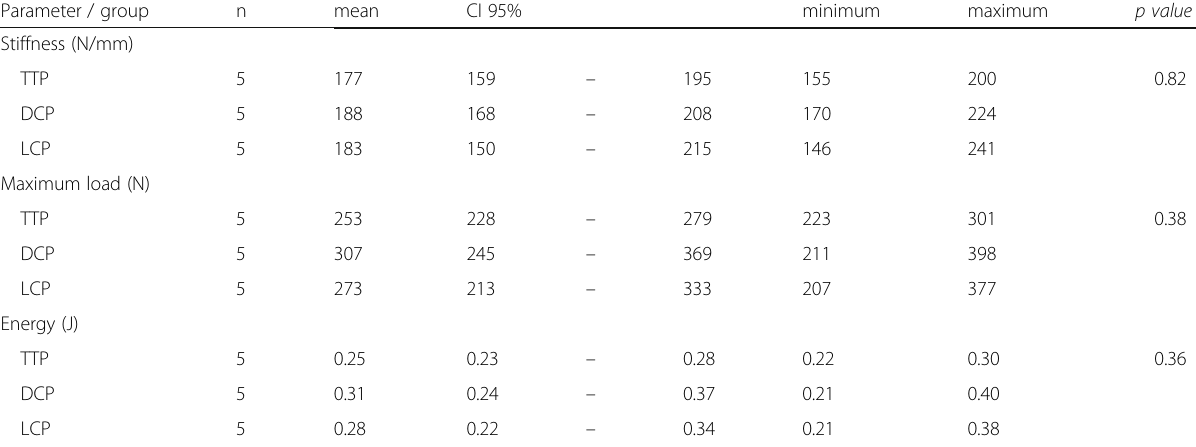
Table 1 Subsidence of the posteromedial fragment up to 2 mm (Stage 1 – TTP vs DCP vs LCP group) Parameter / group n mean CI 95% Stiffness (N/mm)